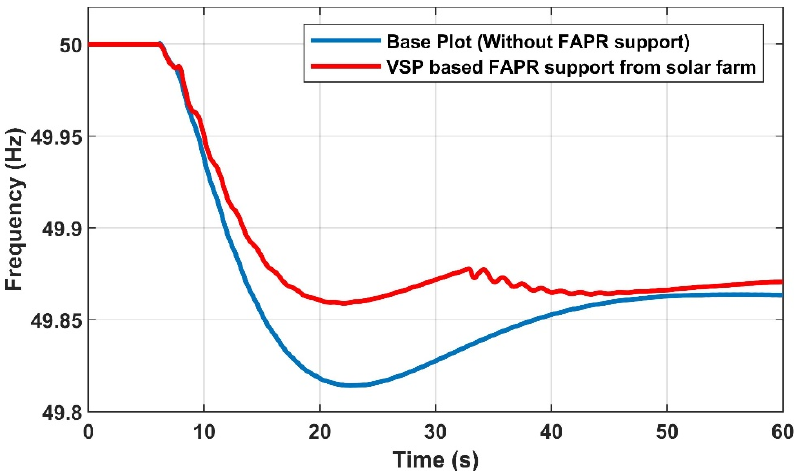
Figure 10. Frequency response due to the support of a solar PV farm with VSP-based FAPR.